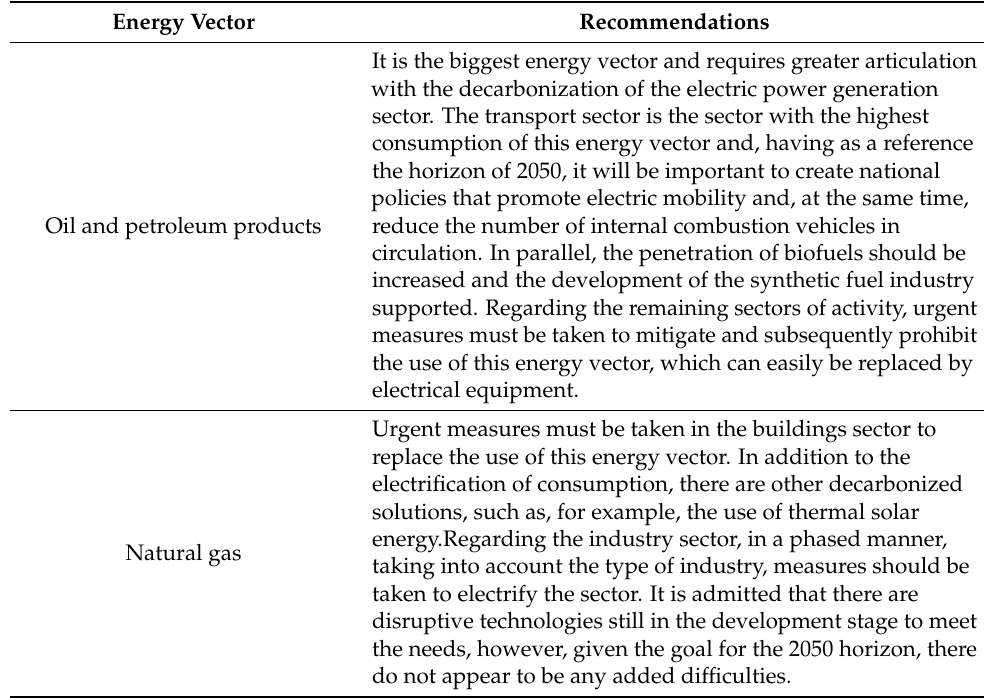
Table 5. Status of the energy vectors in final energy